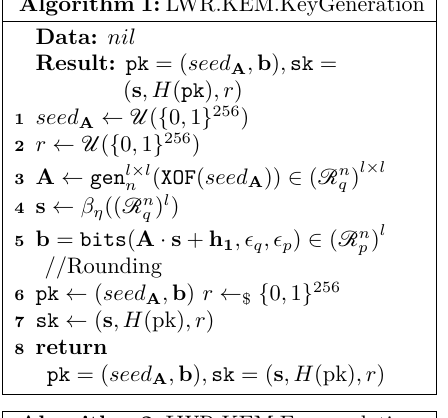
Algorithm 2: LWR.KEM.Encapsulation